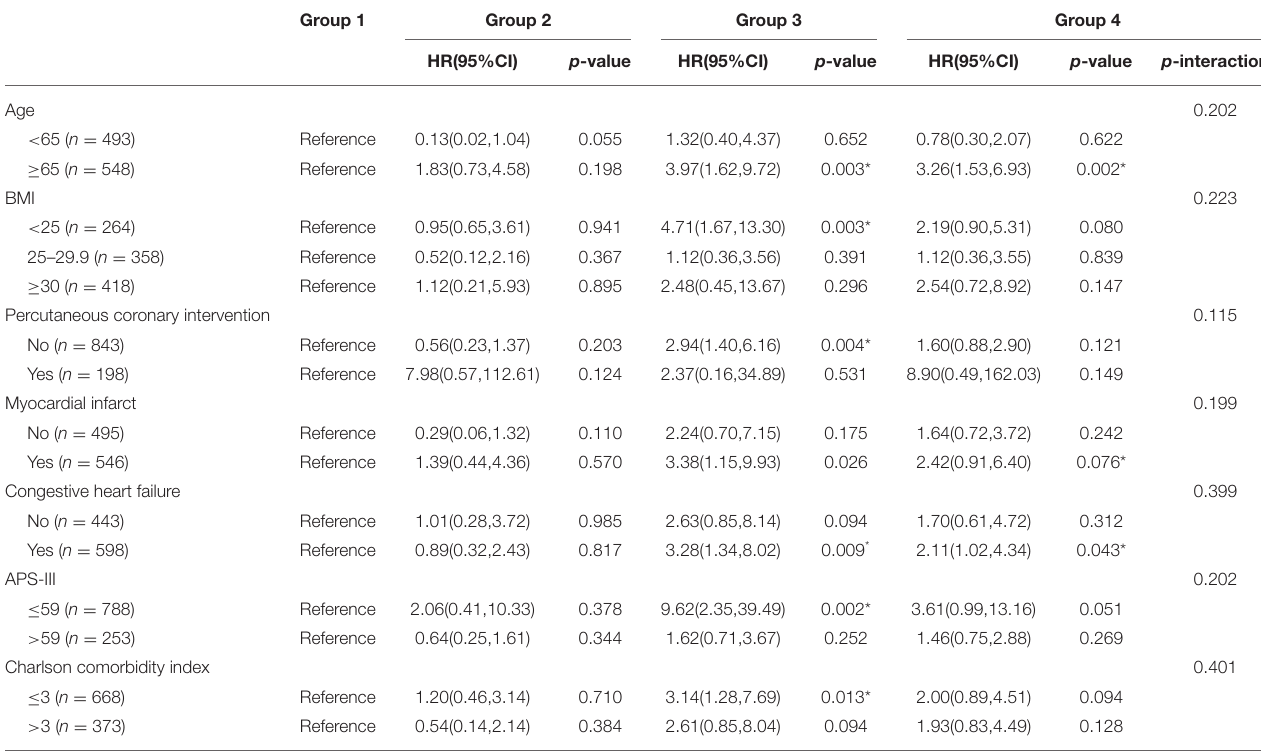
TABLE 3 | Subgroup analysis of the associations between all-cause mortality and length of